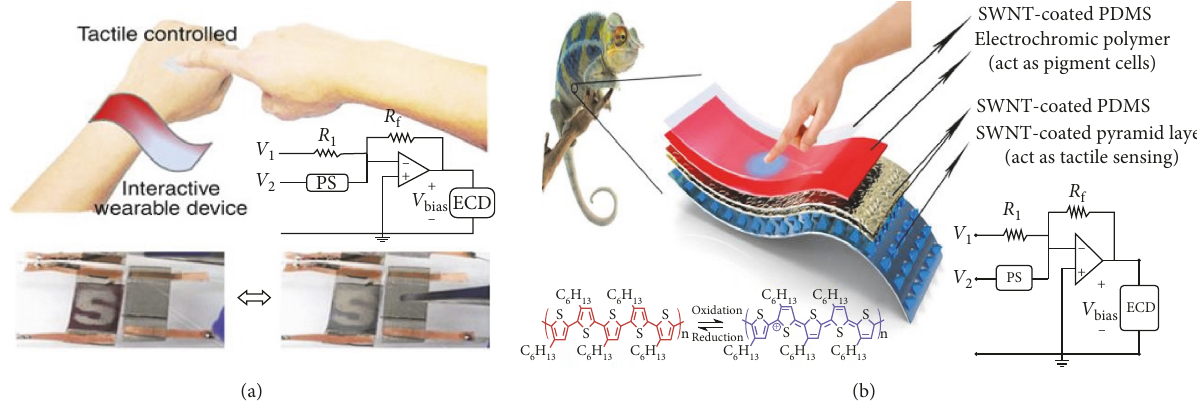
Figure 6: (a) Schematic illustration showing the concept of a chameleon-inspired e-skin, showing the structure of the neutral and oxidized states of electrochromic polymer, also schematic of the circuit layout (PS, pressure sensor; ECD, electrochromic device). (b) The schematic layout of interactive color-changeable e-skin (reproduced with permission from Ref. [94], copyright 2015, Nature publishing